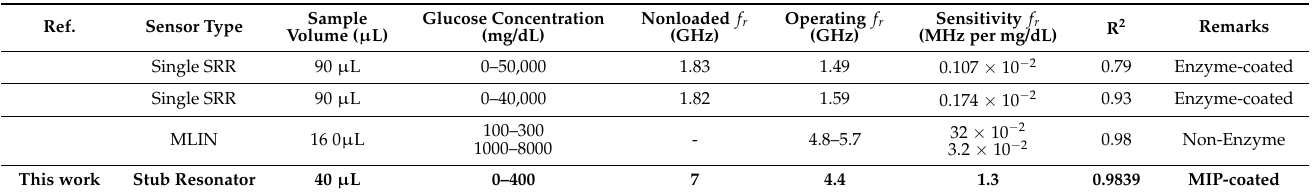
Table 2. Comparison with the state-of-the-art the MIP-coated microwave-based biosensor.